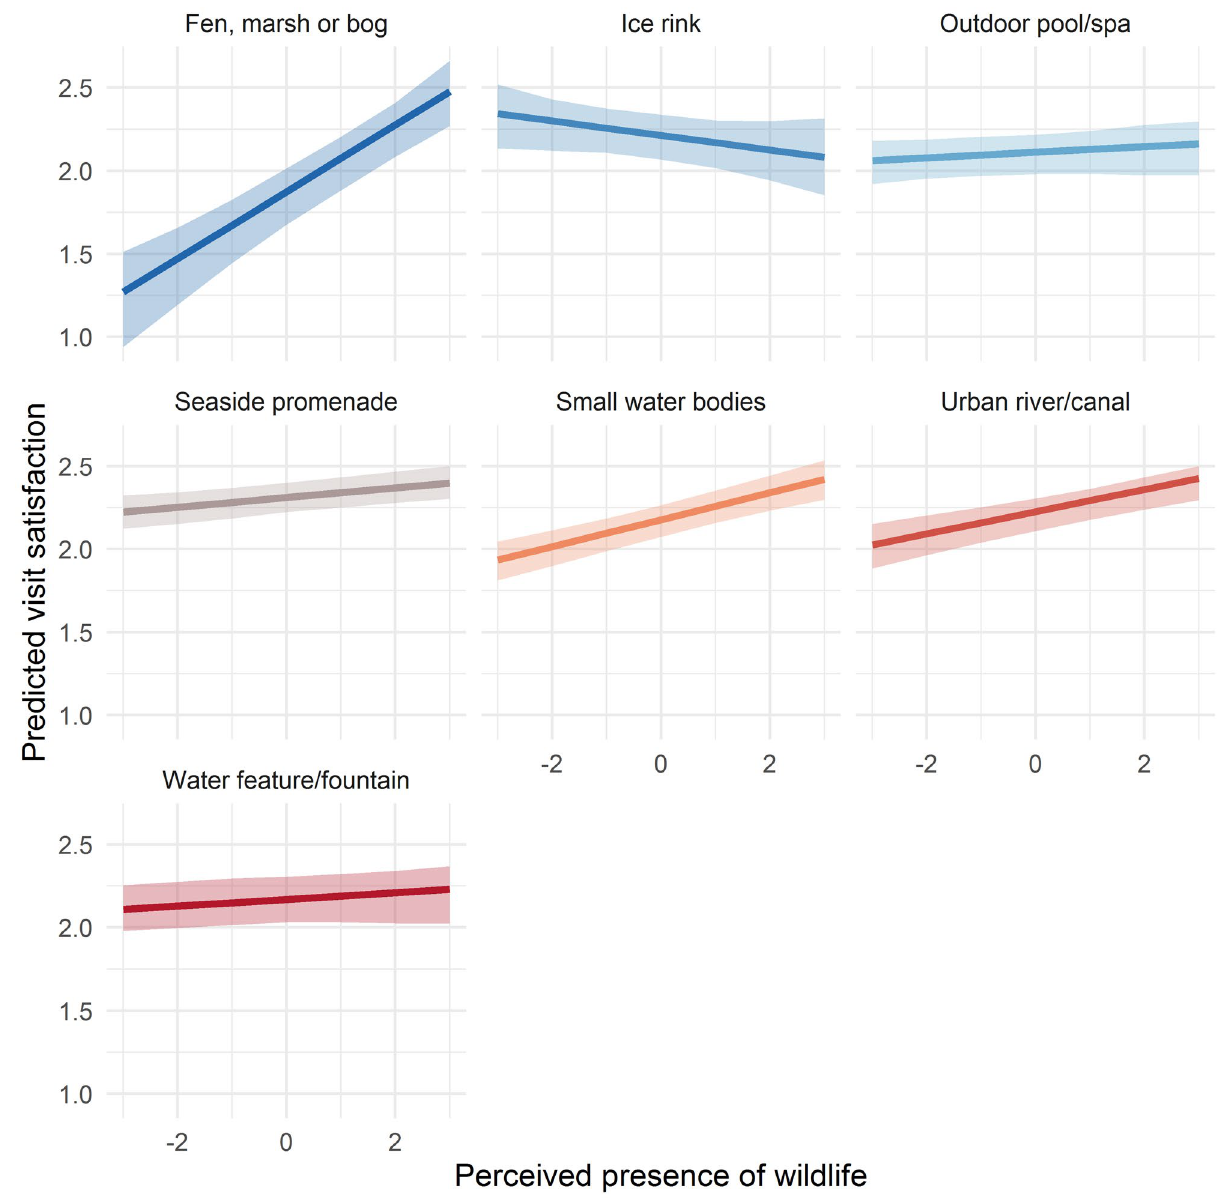
Figure 5. Predicted visit satisfaction by bluespace and wildlife. Predicted visit satisfaction (with 95% confidence interval) estimated from a fully adjusted linear mixed effects model with an interaction effect between wildlife and bluespace type. Other variables were fixed where safety, litter and facilities = 2; water quality = sufficient, proximity = < 15 min travel; visit duration = 1–1.5 h; activity = walking without a dog; companions = alone; travel mode = private vehicle; start point = home; financial strain = coping; age = 18–29; sex = male; presence of limiting illness/disability = no; garden = no access; employment status = employed; educational attainment = university; member of ethnic minority = no; relationship status = married/cohabiting; dog ownership = no; wave = June 2017; country = United Kingdom and WHO-5 well-being = 80. Environments displayed where the interaction was significant in comparison to the grand mean for bluespace x wildlife (Table